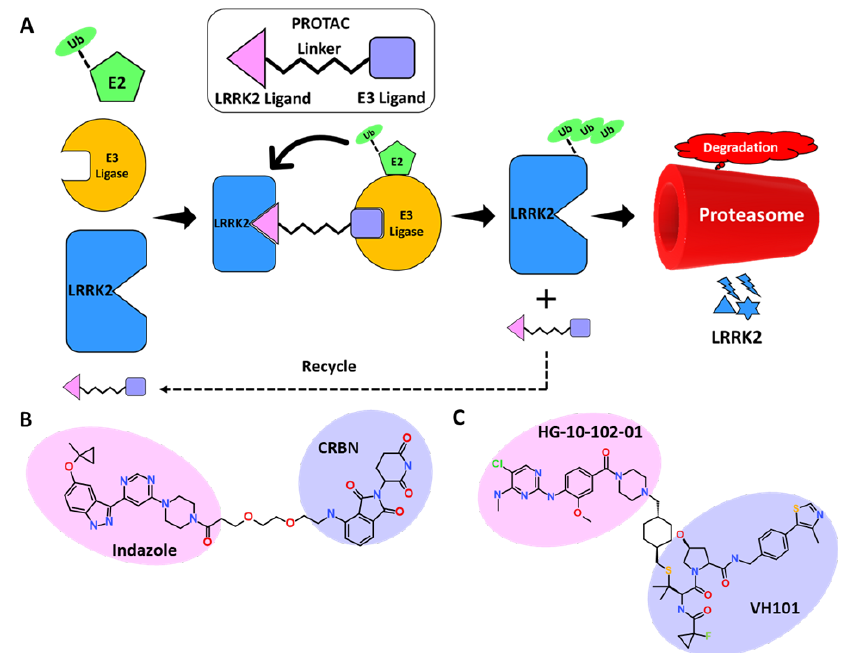
Figure 5. ( A ) Schematic representation of the assembly of PROTAC machinery. ( B , C ) Representative PROTAC developed against LRRK2. PROTAC developed against